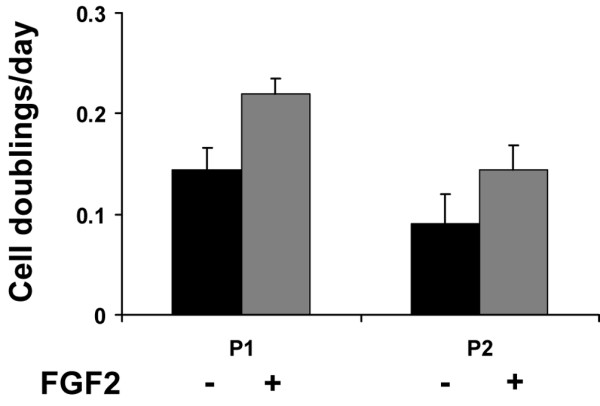
Cell doubling for P1 and P2 meniscus cells in the presence and absence of FGF2. Results are expressed as means ± SD (n = 4). FGF2, fibroblast growth factor 2; P1, passage 1; P2, passage 2.